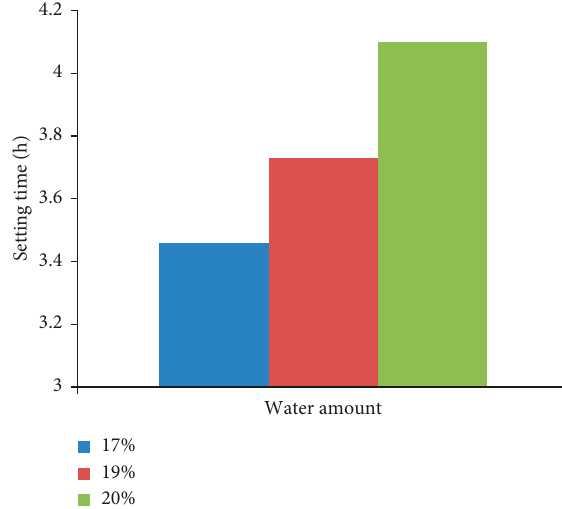
Figure 7: Influence of water amount on ordinary dry mortar setting